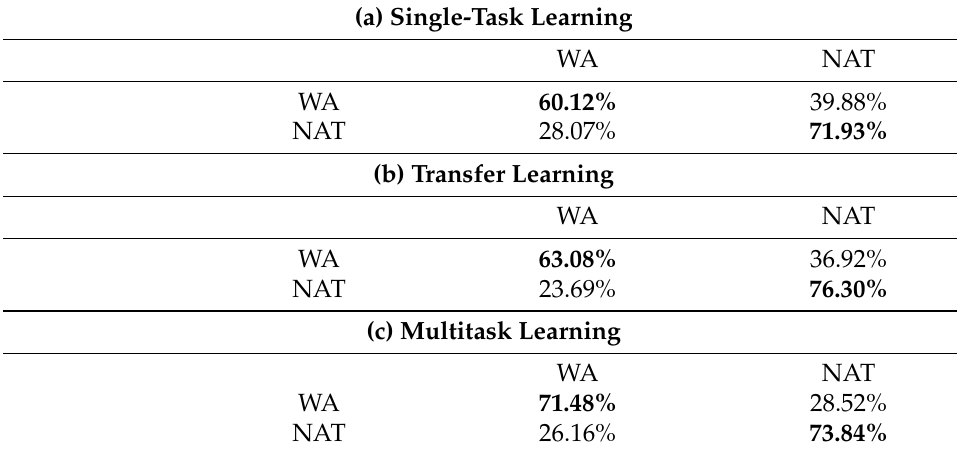
Table 5. Confusion matrices on video patches of the transfer-learning (a) and multitask learning (b) models sharing the constrained and conv1